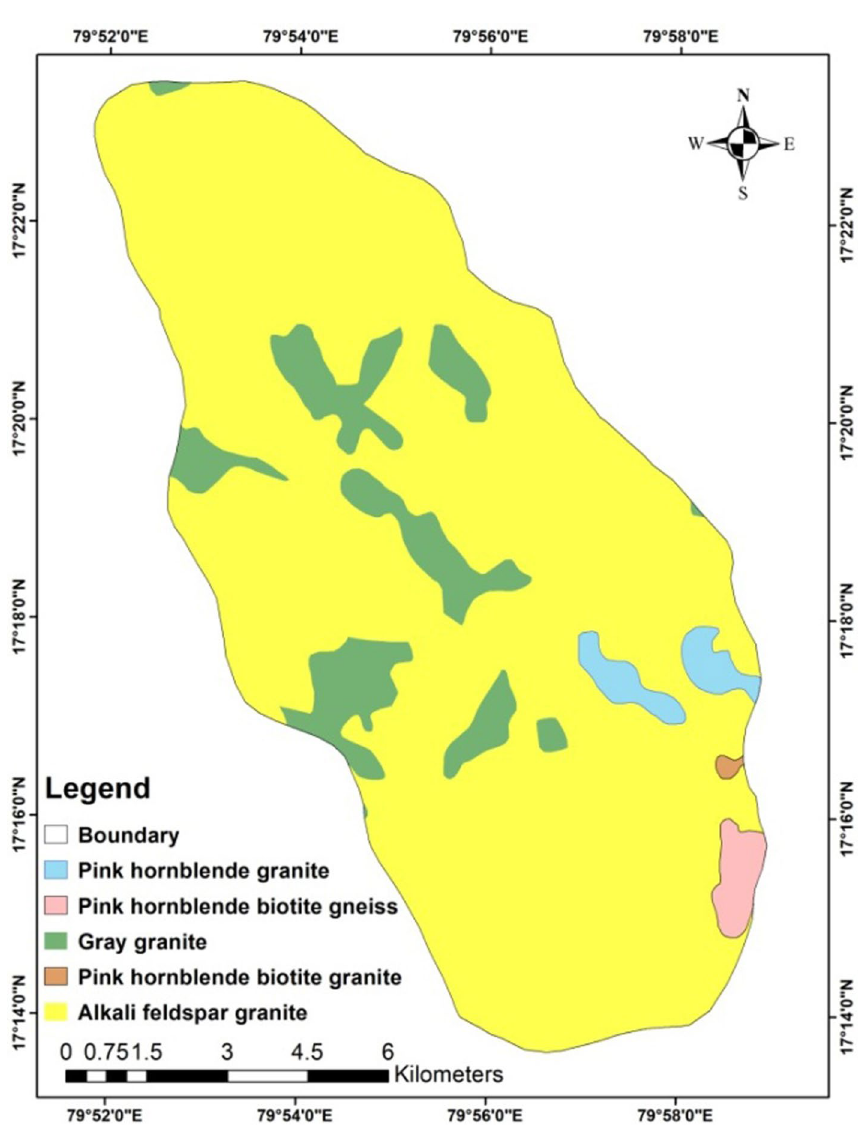
Fig. 2 Geology map of the Subledu